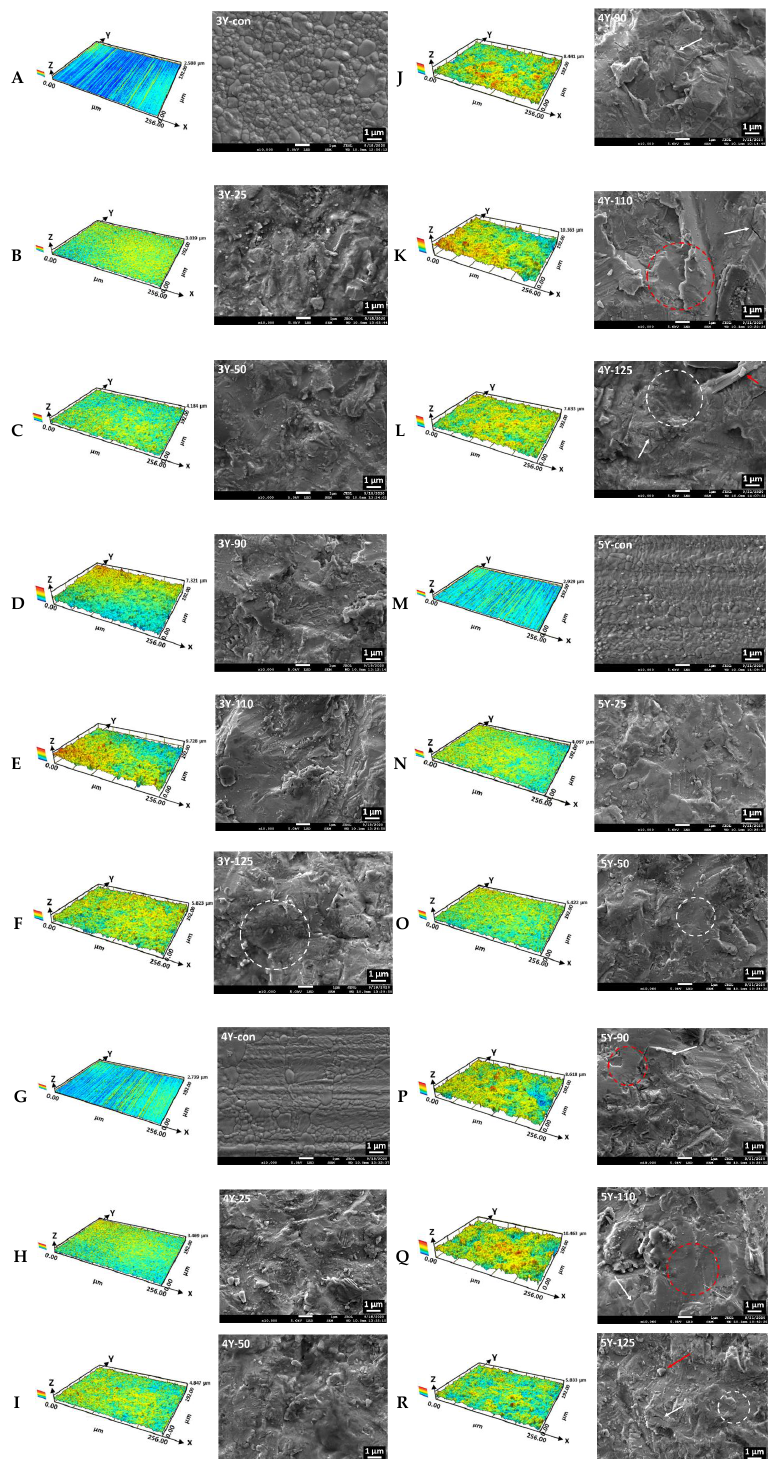
Figure 4. Three-dimensional representations obtained by confocal laser scanning microscopy and scanning electron microscopic images (magnification 10,000×) of each subgroup. For the SEM images, the white arrow indicates a micro-crack; the red arrow indicates Al 2 O 3 particle debris deposited on the abraded zirconia surface; the white circle indicates plastic deformation; the red circle indicates surface melting. ( A ) 3Y-con.; ( B ) 3Y-25.; ( C ) 3Y-50.; ( D ) 3Y-90.; ( E ) 3Y-110.; ( F ) 3Y-125.; ( G ) 4Y-con.; ( H ) 4Y-25.; ( I ) 4Y-50.; ( J ) 4Y-90.; ( K ) 4Y-110.; ( L ) 4Y-125.; ( M ) 5Y-con.; ( N ) 5Y-25.; ( O ) 5Y-50.; ( P ) 5Y-90.; ( Q ) 5Y-110.; ( R ) 5Y-125.